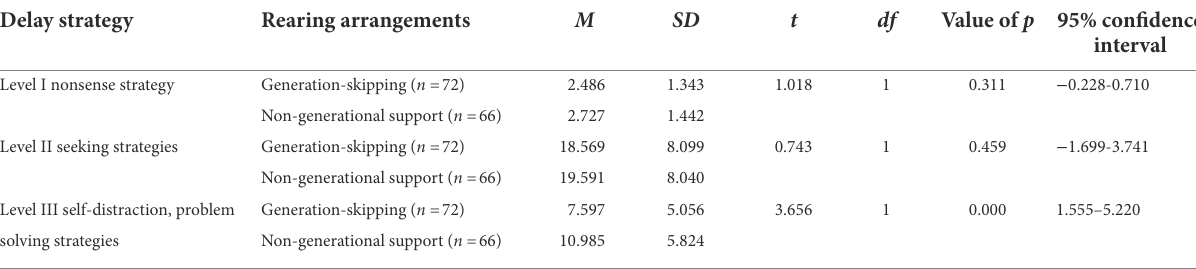
TABLE 3 The t -test results of the scores of each level of children’s delay strategy under different rearing arrangements. Delay strategy